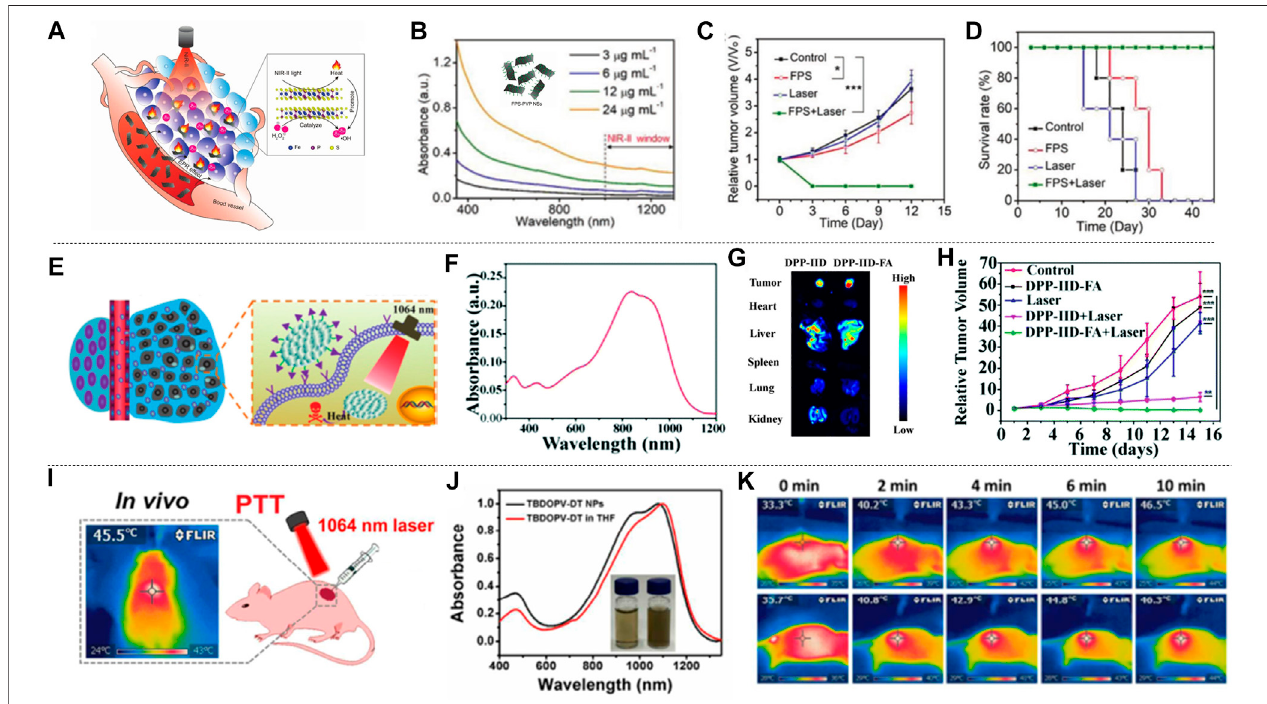
FIGURE 9 | Photothermal treatment of cervical cancer. (A) FPS-PVP NSs are used in the synergistic treatment of cancer chemodynamic therapy and PTT in the NIR- Ⅱ .Theillustration isthebatmodel ofFPS. (B) UV-vis-NIRabsorbancespectraofFPS-PVPNSsat differentFeconcentrations(3,6,12,and24 μ g ml − 1 ). (C) Growth curves of mouse tumors at 12 days after different treatments ( n (cid:2) 5). (D) The survival rate of mice after 12 days of different treatments (reproduced from (Zhang et al., 2020) with permission from Wiley-VCH Verlag). (E) Schematic diagram of DPP- Ⅱ D-FA nanoparticles for photothermal treatment of super fi cial tumors. (F) AbsorptionspectrumofDPP- Ⅱ D-FAnanoparticlesdispersedinPBS. (G) Exvivo fl uorescenceimageofmousemainorgans24 hafterDPP- Ⅱ D-FAnanoparticleinjection. (H) Relative tumor volumes after varioustreatments (reproduced from (Weiet al., 2018) with permission from Royal Society ofChemistry). (I) ApplicationofTBDOPV-DT NPs in PTT in vivo . (J) Absorption spectra and picture (inset) of TBDOPV-DT NPs (water, right) and TBDOPV-DT (THF, left). (K) The whole-body IR images of mice after injection of TBDOPV-DT NPs intratumorally (0.56 mg kg − 1 ) and irradiated by 1,064 nm laser (0.90 W cm − 2 ) or intravenously (1.94 mg kg − 1 ) and irradiated by laser (1.30 W cm − 2 ) (reproduced from (Sun et al., 2018) with permission from American Chemical Society).